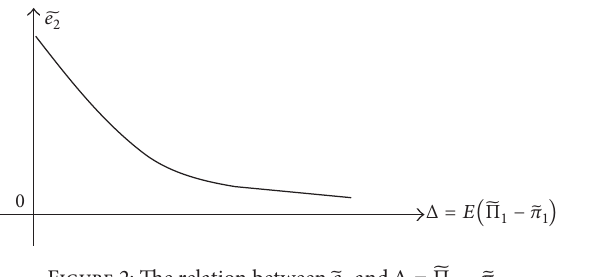
Figure 2: The relation between ̃𝑒 2 and Δ =